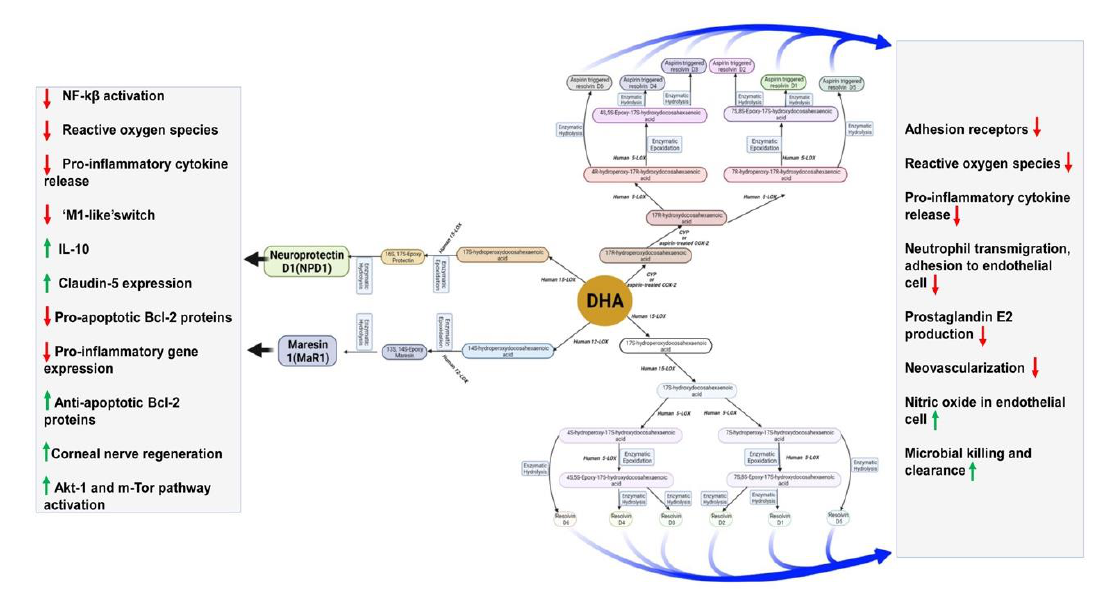
Figure 3. DHA metabolites formation and function in the brain. Maresin 1(MaR1), neuroprotectin D1(NPD1), and resolvins are produced from DHA